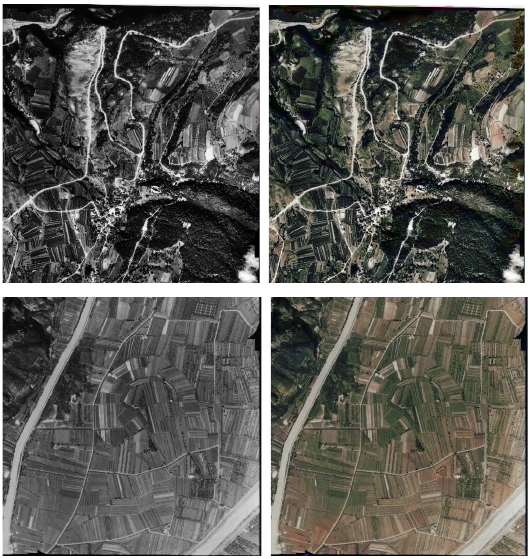
Figure 10. Example of colorization